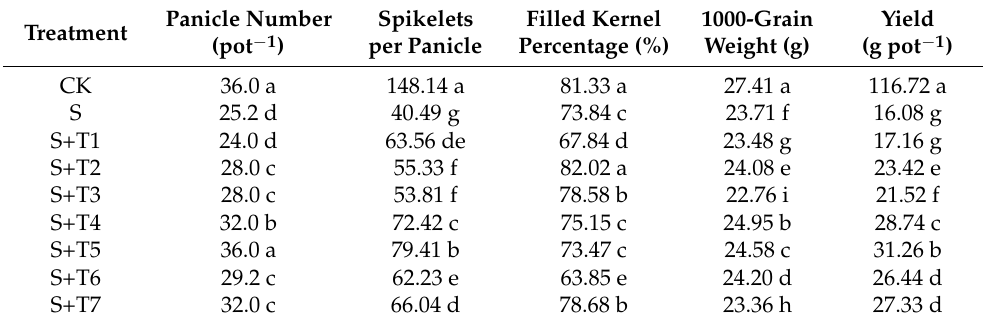
Table 7. Rice grain yield and its components.